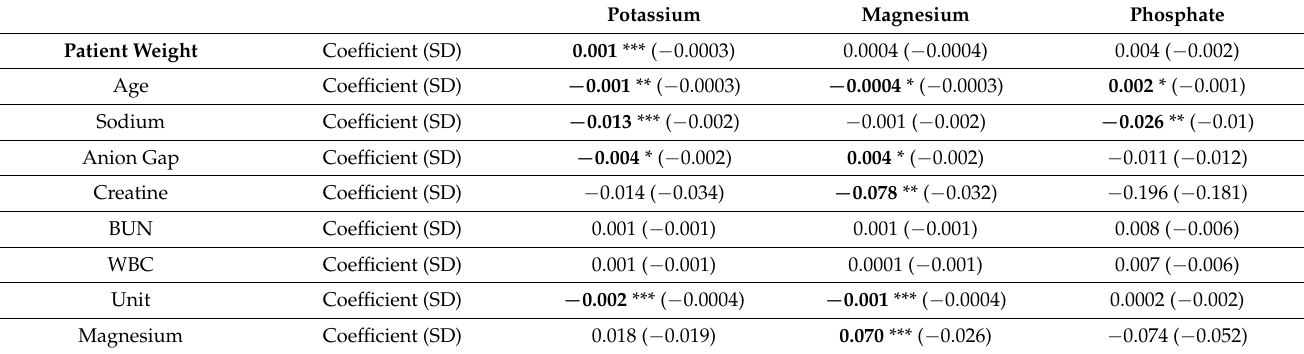
Table 2. Regression analysis for the factors contributing to the decision to replace